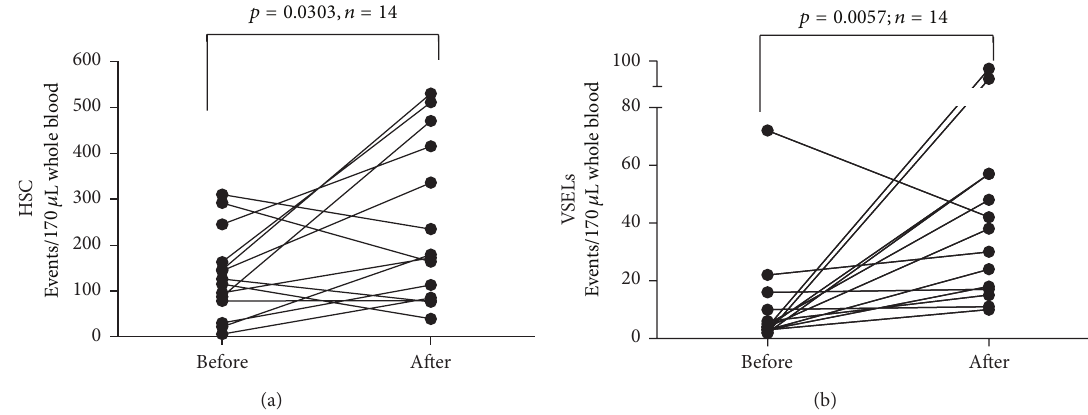
Figure 3: Summary of analyses of time-course changes of the numbers of HSCs (a) and VSELs (b) during FSH therapy.